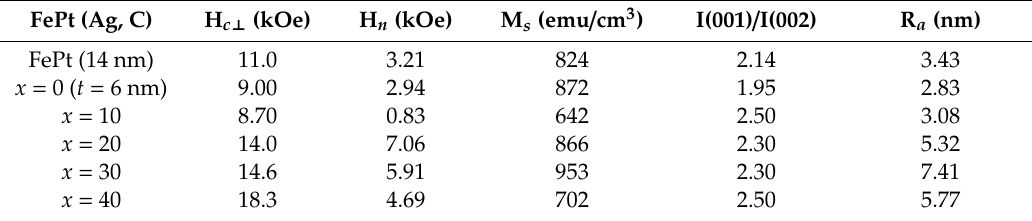
Figure 3. ( a ) XRD patterns of sample series (II), FePt(6 nm)(Ag, C)(x vol %) / [MgTiTaON (1 nm) / FePt(4 nm)(Ag, C)(x vol %)] 2 ( x = 0, 10, 20, 30, 40). Rocking curves of ( b ) reference sample (ref), and ( c ) x = 30. Table 2. Out-of-plane H c , nucleation field ( H n ), saturation magnetization ( M s ), Integrated intensity ratio (I(001) / I(002)), surface roughness ( R a ) of reference sample FePt (14 nm), and sample series (II) FePt(6 nm)(Ag,C)(x vol %) / [MgTiTaON (1 nm) / FePt(4 nm)(Ag,C)(x vol %)] 2; ( b ) x = 0; ( c ) x = 10; ( d ) x = 20; ( e ) x = 30; ( f ) x = 40.